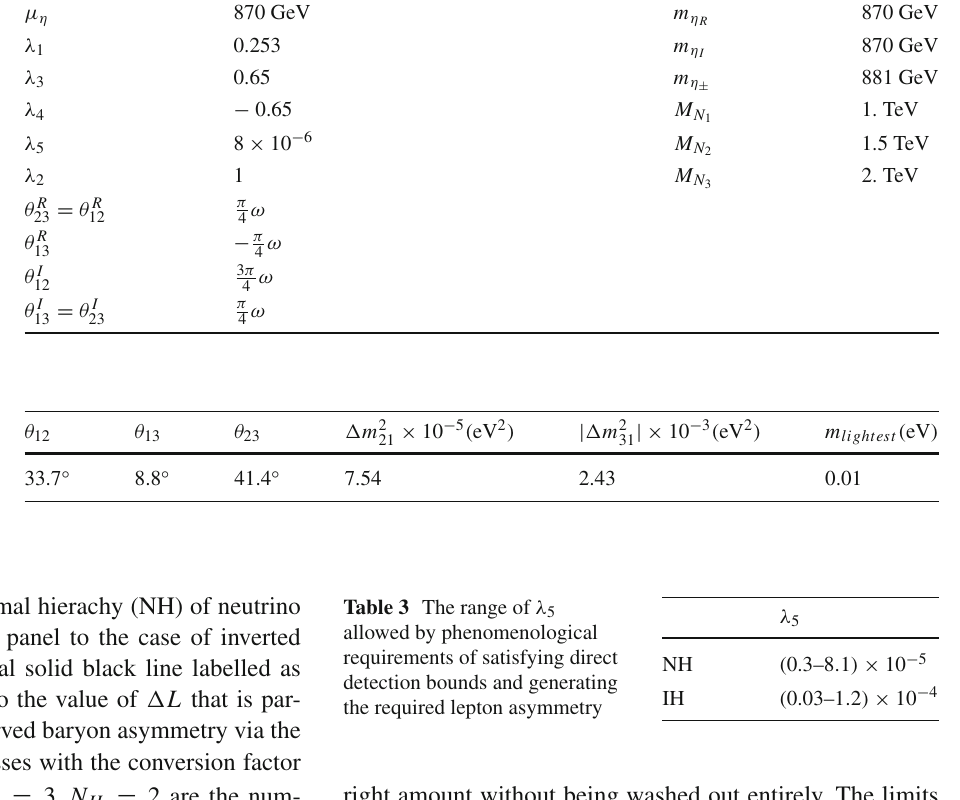
Table 1 The numerical values of the parameters chosen for generating correct scalar DM relic and baryon asymmetry. We denote it as benchmark point 1 (BP1). The fraction ω is to ensure to get the correct baryonic asymmetry. For Normal (Inverted) Hierarchy ω = 0 . 7 ( 0 . 56 )